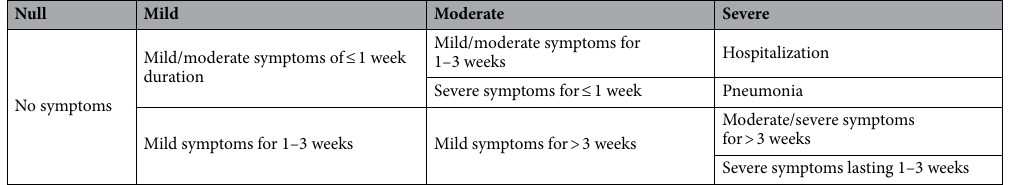
Table 5. COVID-19 symptomatology used to define severity of disease. Symptoms Cough, disnea, expectoration (lower respiratory tract secretions), rhinorrhoea, sore throat, chills, fever (mild: ≥ 37.5–< 38 °C; moderate: ≥ 38–< 39 °C ; severe: ≥ 39 °C), diarrhea (mild: < 4 depositions/day; moderate: 4–7 depositions/day; severe: > 7 depositions/day), nausea, vomiting, headache, dizziness, fatigue and myalgia, anosmia, dysgeusia, musculoskeletal pain, loss of appetite, sadness or